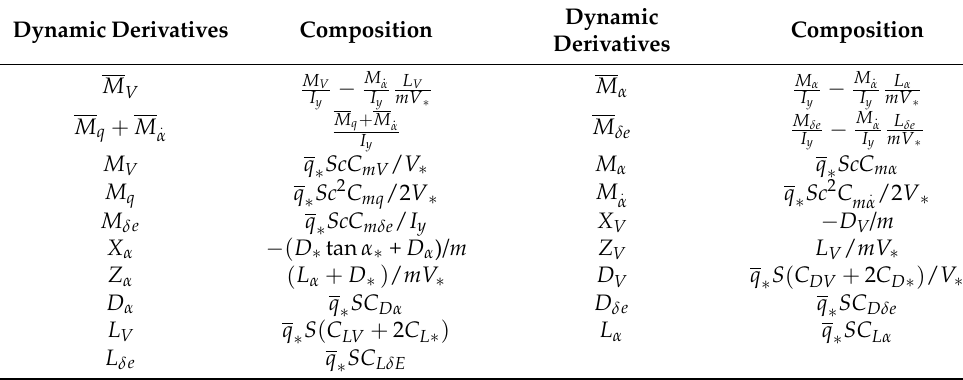
Table 2. Longitudinal dynamic